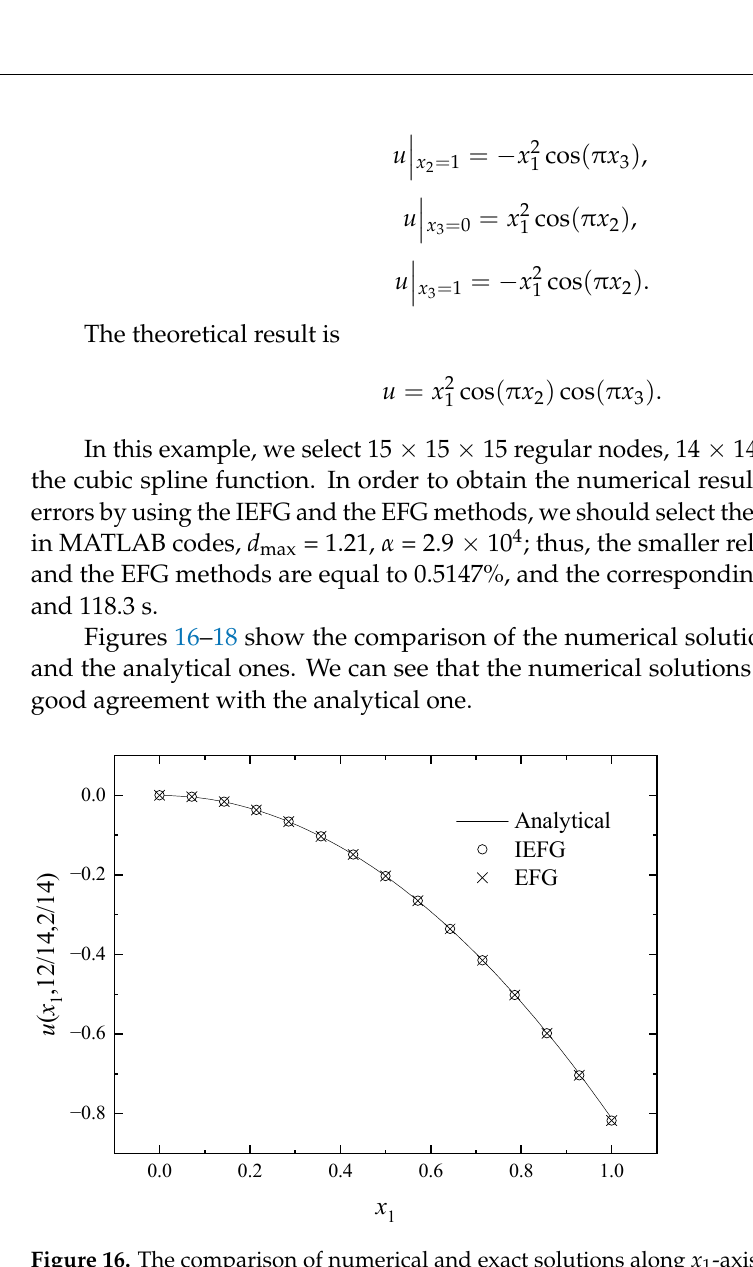
Figure 16. The comparison of numerical and exact solutions along x 1 -axis.